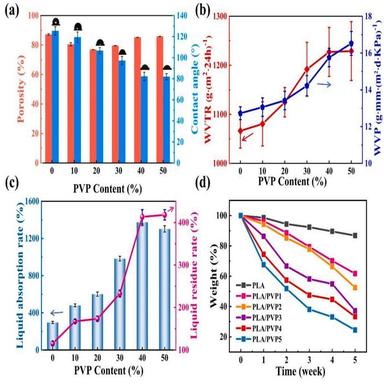
Hydrophilicity and degradability of PLA/PVP crosslinked nanofiber membranes: (a) Porosity and contact angle, (b) Water vapor permeability, (c) Liquid absorption and (d) In vitro degradation.